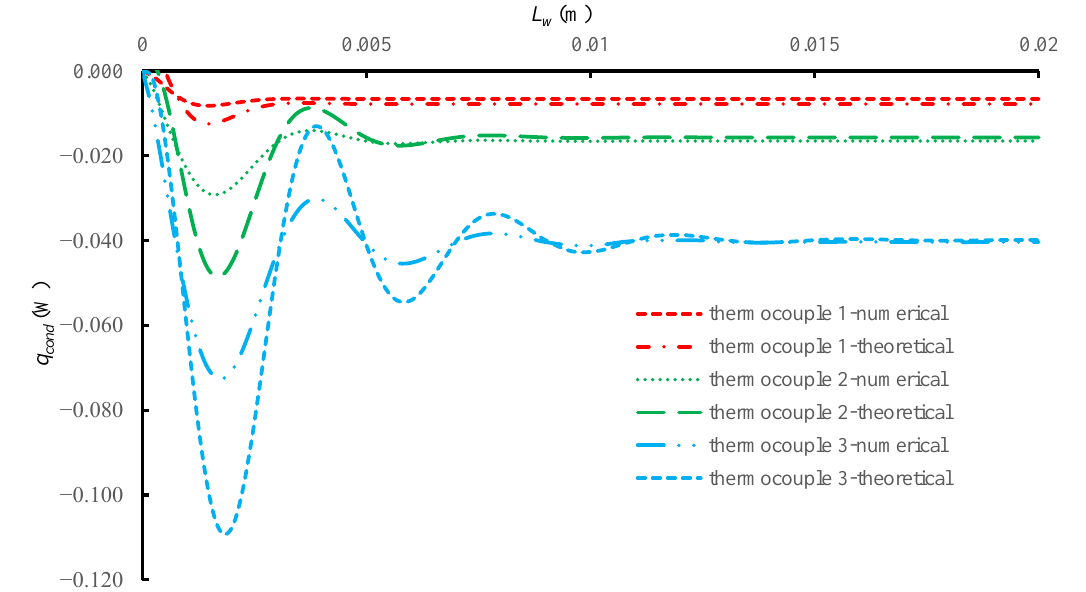
Figure 7. Numerical and theoretical q cond variation with L w. Table 1. Effective length of three